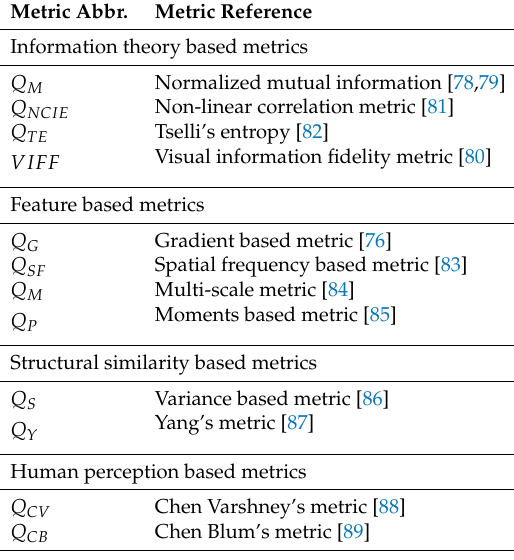
Table 2. Objective image fusion quality assessment metrics used in performance evaluation of the compared